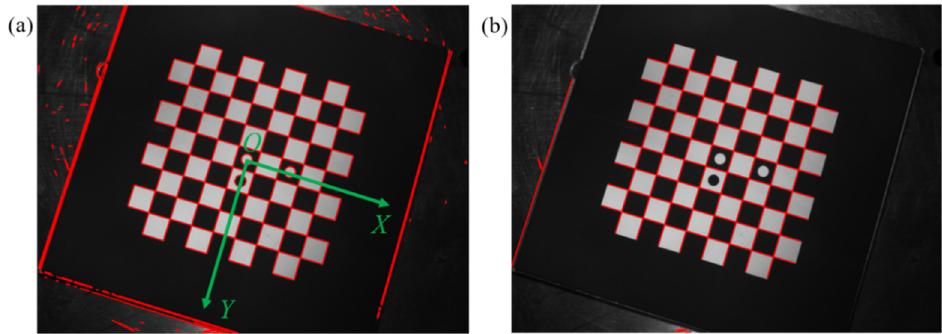
Figure 2. Comparison of results before and after straight-line screening: ( a ) EDLines test results, ( b ) straight-line filter results.